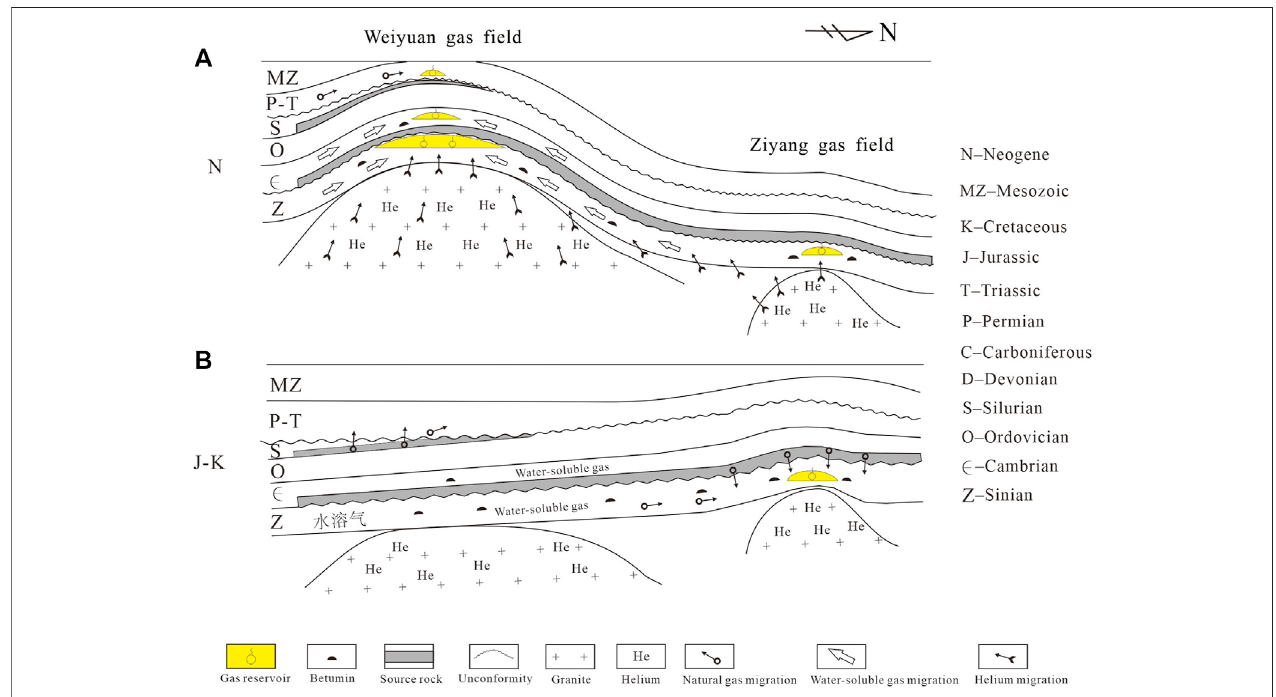
FIGURE 10 | The helium Enrichment mechanism of Weiyuan gas fi eld. (A) Structure map after the Himalayan period. (B) Structure map before the Himalayan period.